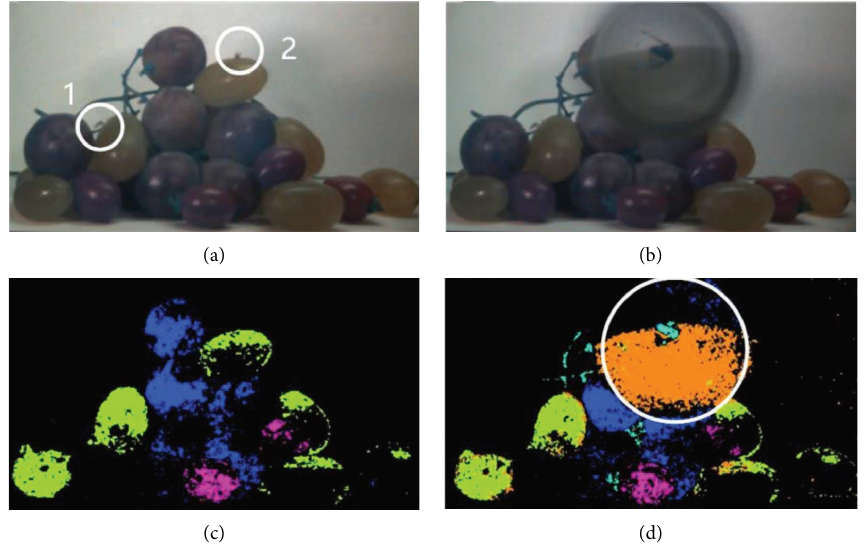
Figure 13: Drosophila and fruit classifcation. (a) Artifcial color image without a foveated zoom lens group. (b) Foveated magnifed color image of Drosophila in region 2. (c) Classifcation image of (a). (d) Classifcation image of